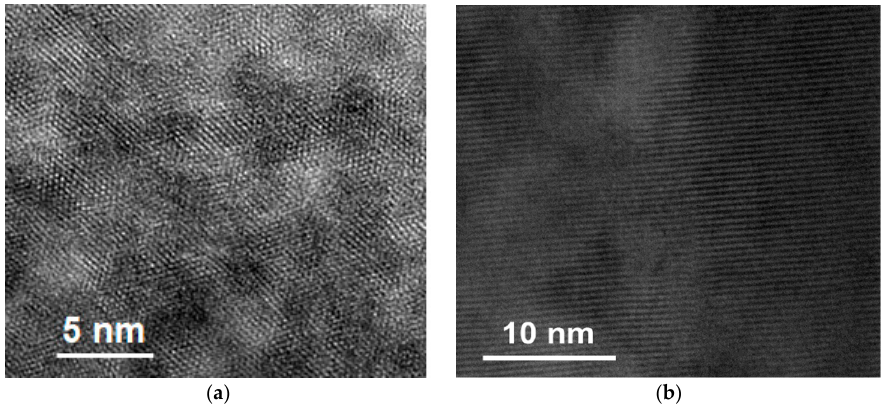
Figure 4. The transmission electron microscope (TEM) micrograph of Cu-Al/SiO 2 porous material with cetyltrimethylammonium bromide (CTAB). ( a ) parallel to the pore direction; ( b ) perpendicular to the pore direction.